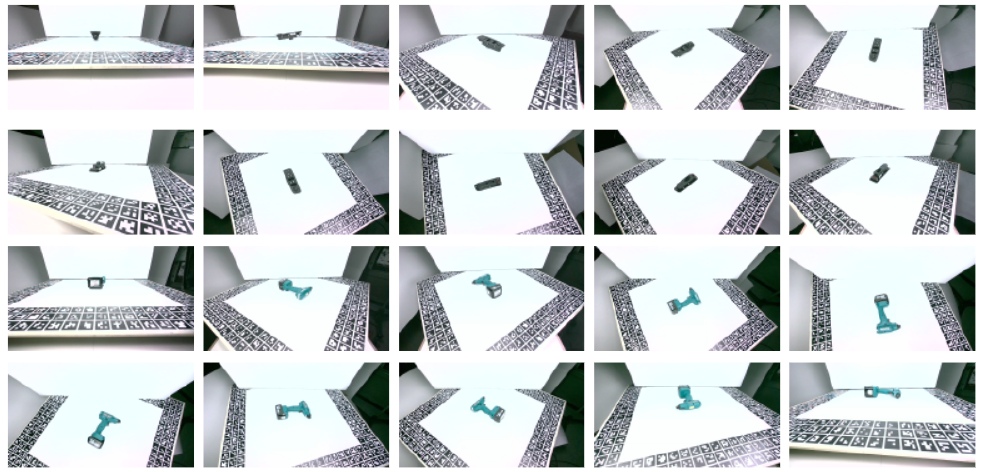
Figure 8. Sample images from the dataset created in the laboratory for the window control panel (rows 1 and 2) and the screwdriver (rows 3 and